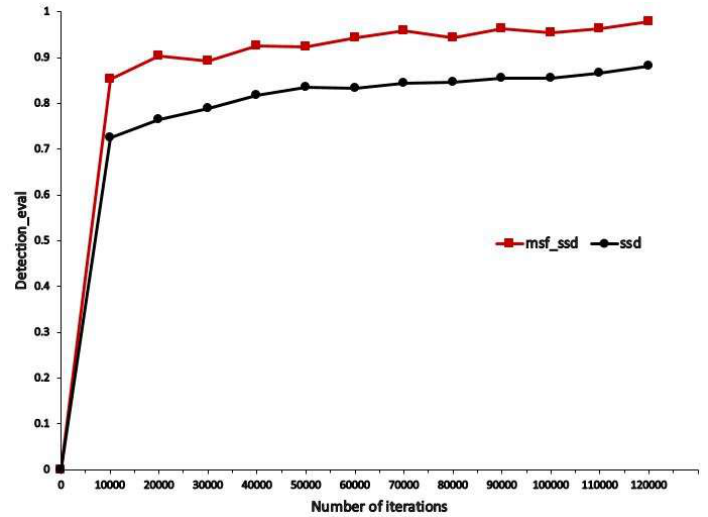
Figure 10. Training accuracy on track and field train samples of MSF_SSD and SSD.